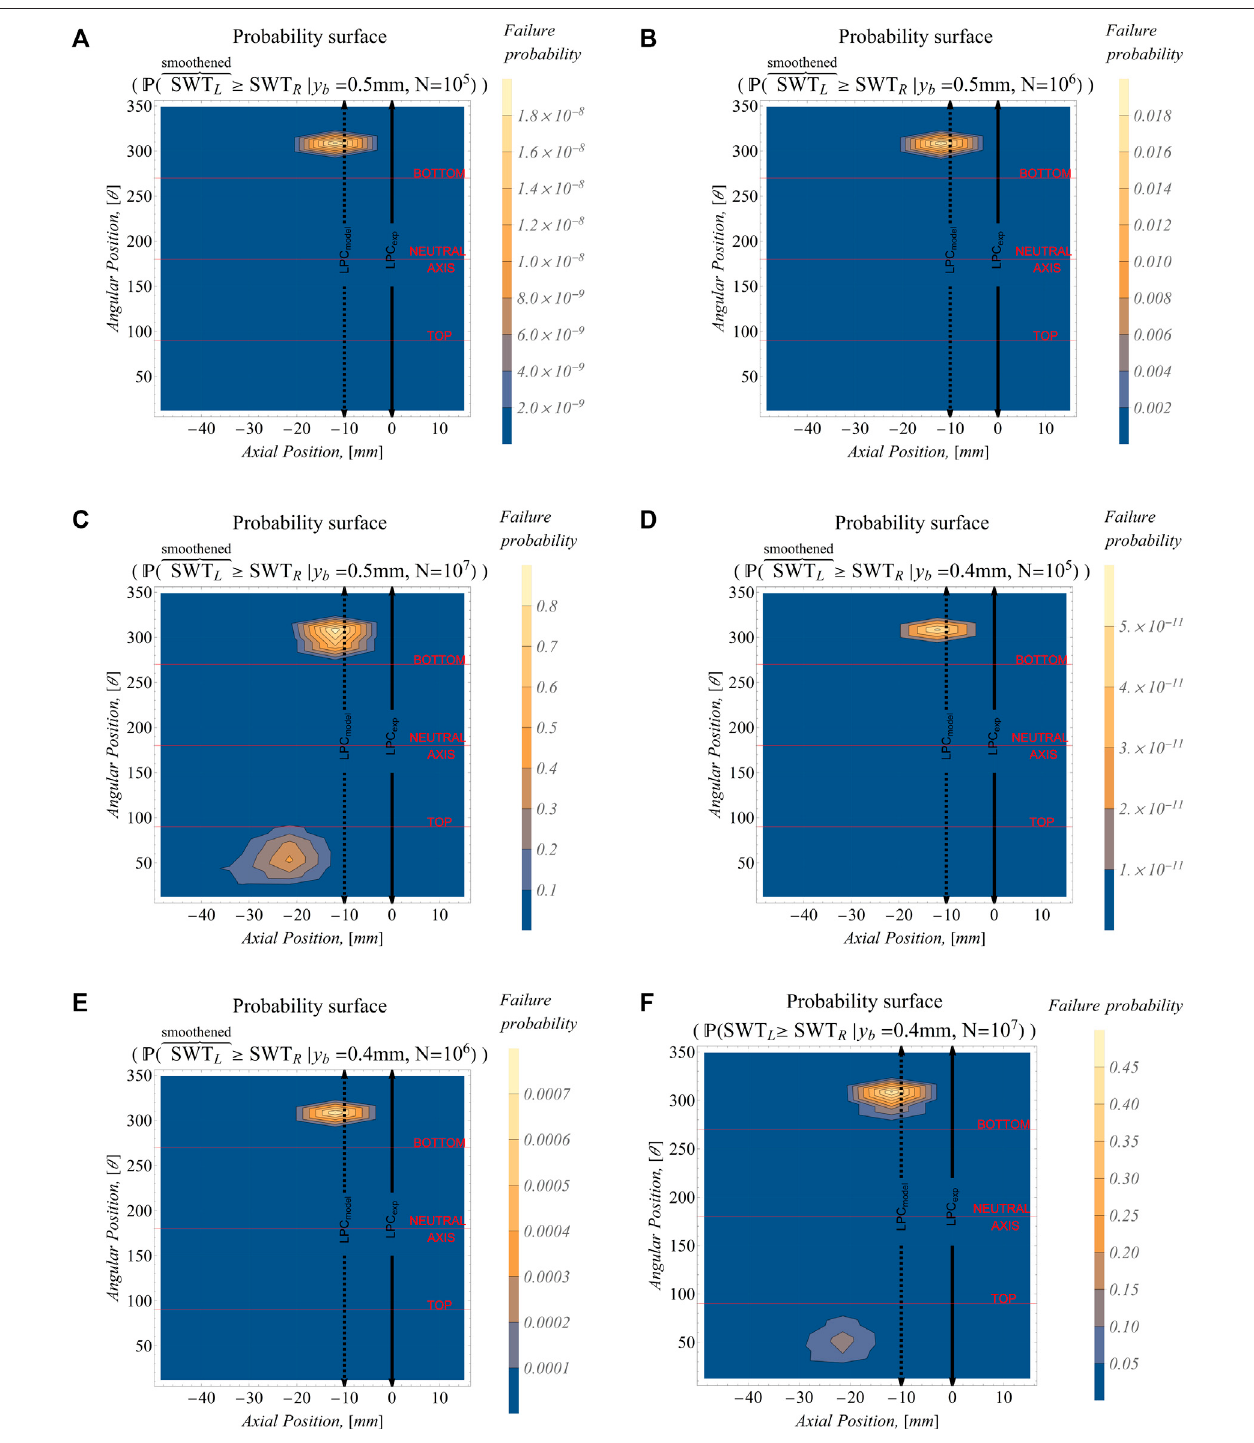
FIGURE 14 | Probability of failure for the wires in layer 4 of the Bersfort conductor at a bending amplitude of 0.5 mm (A – C) and 0.4 mm (D – F) .